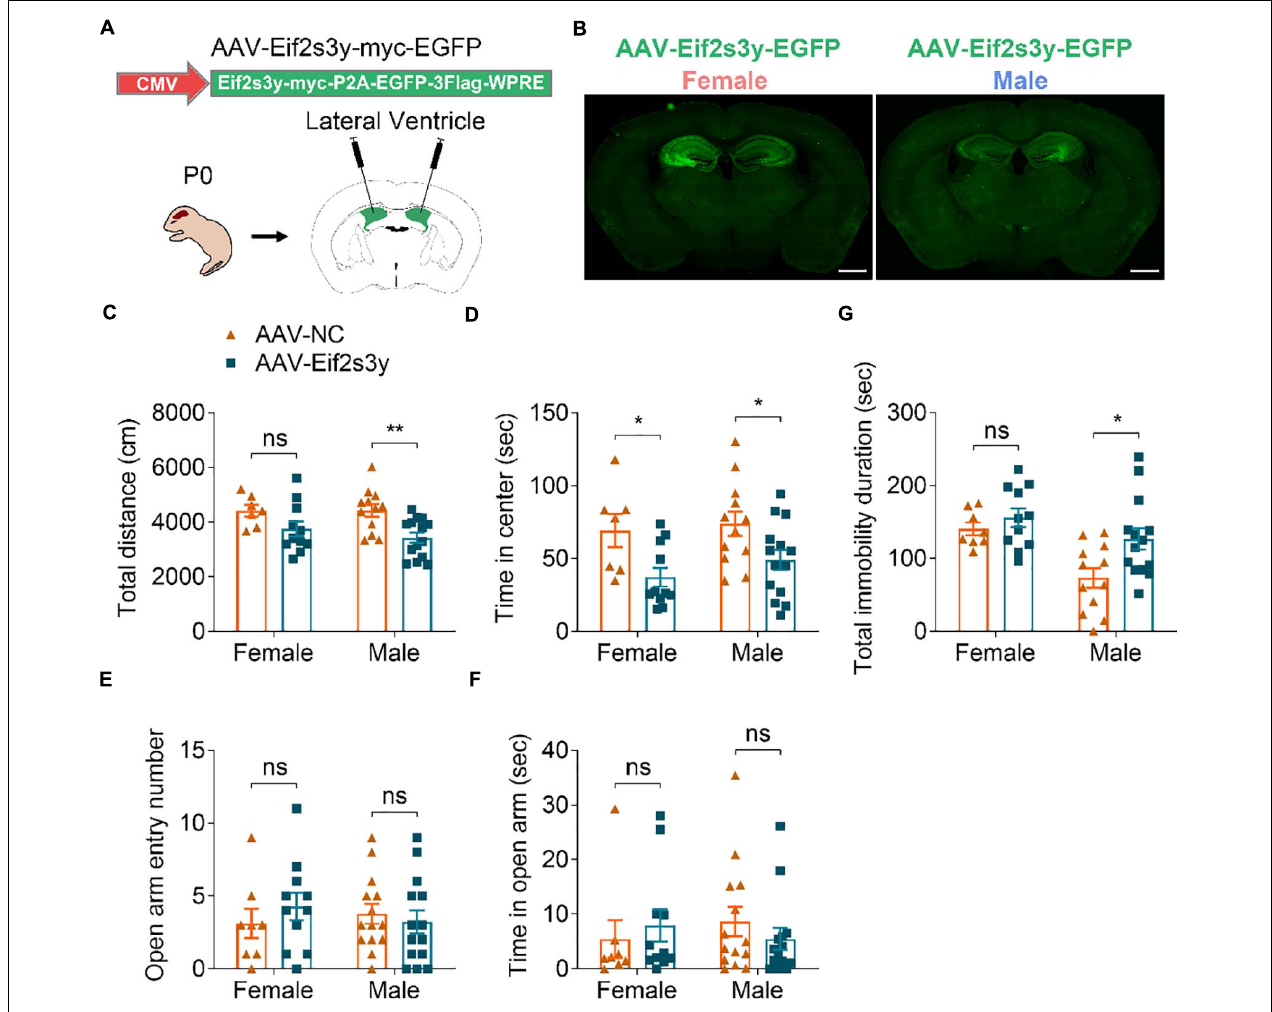
FIGURE 5 | Overexpression of Eif2s3y causes male-specific depression-like behavior. (A) Scheme of the AAV injection paradigm. (B) Representative images of the EGFP expression localization in male and female mice injected with AAV-Eif2s3y. Scale bar, 1 mm. (C,D) In the open-field test, total travel distance (C) and time in the center (D) were analyzed. n = 14 AAV-Eif2s3y male mice, n = 12 AAV-NC male mice, n = 11 AAV-Eif2s3y female mice, and n = 7 AAV-NC female mice. (E,F) In the elevated plus-maze test, time spent in the open arm (E) and open arm entry numbers (F) were analyzed. n = 14 AAV-Eif2s3y male mice, n = 14 AAV-NC male mice, n = 11 AAV-Eif2s3y female mice, and n = 8 AAV-NC female mice. (G) In the tail suspension test, mouse immobility duration was analyzed. n = 14 AAV-Eif2s3y male mice, n = 12 AAV-NC male mice, n = 11 AAV-Eif2s3y female mice, and n = 8 AAV-NC female mice. Unpaired t-test. * p < 0.05, ** p < 0.01, ns, not